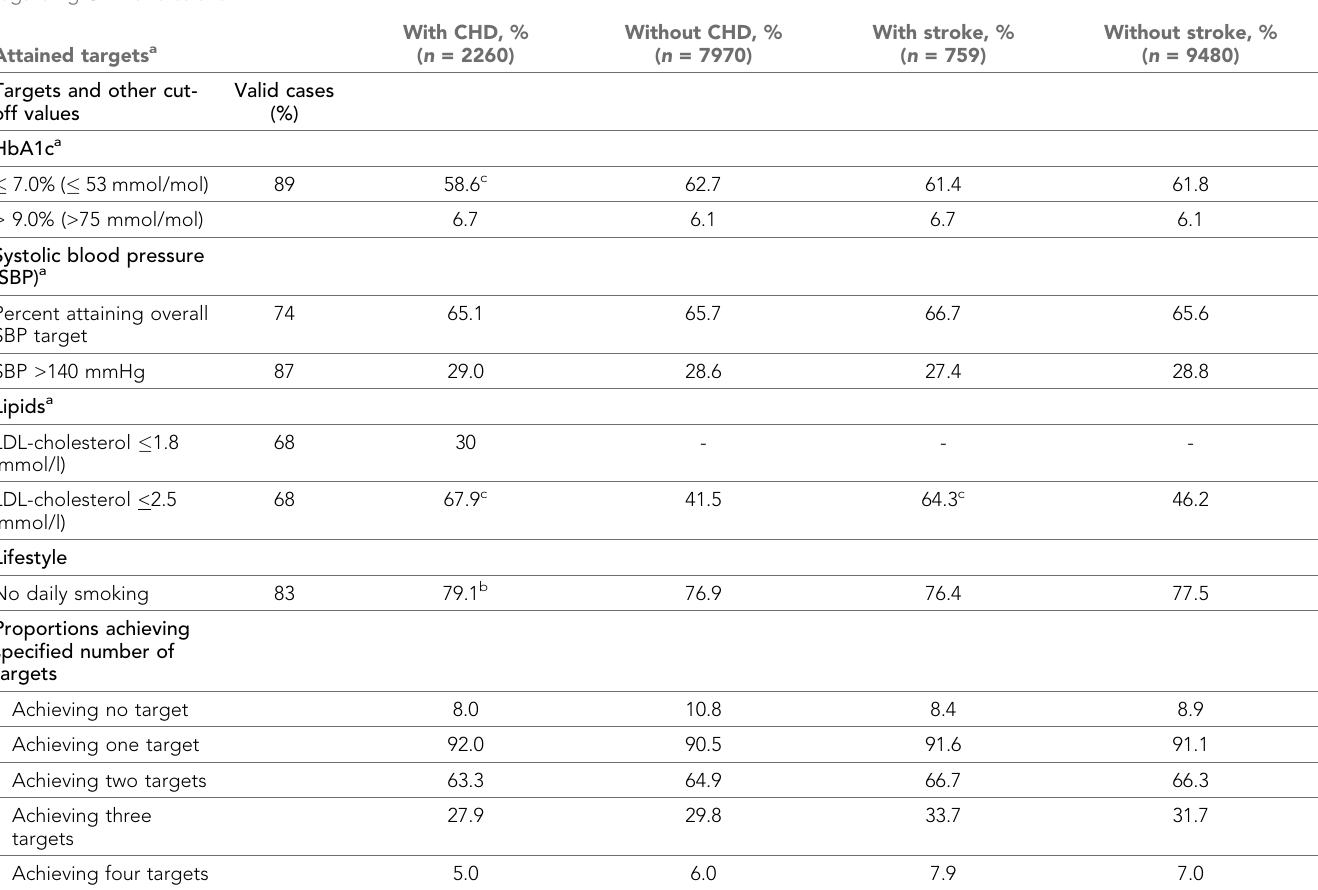
With CHD, % Without CHD, % With stroke, % Without stroke, % ( n = 2260) ( n = 7970) ( n = 759) ( n = 9480)